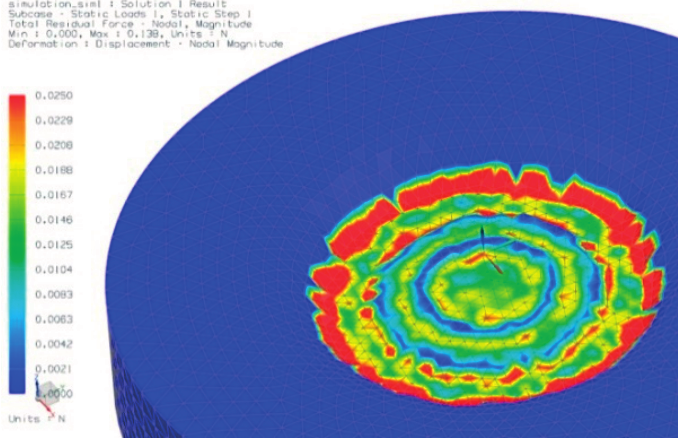
Figure 8. Simulation result of the bulging effect in the gel underneath of the